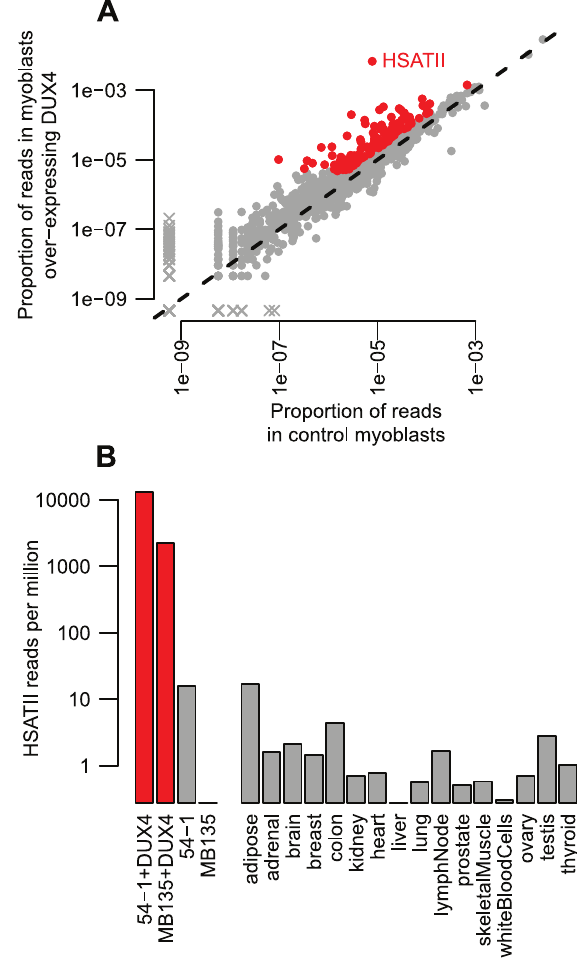
Figure 6. Read-based enrichment analysis of RNA-seq data shows activation of several repeat types. (A) For each repeat type, we show the proportion of RNA-seq reads in two myoblast cell lines transduced with lentiviral DUX4 (y-axis) compared to the proportion from the same two myoblast cell lines without DUX4 transduction (x- axis). Repeats plotted in red show $ 2-fold activation and $ 1000 reads summed across the two DUX4 -expressing myoblast lines. The HSATII repeat is labeled. As in Figure 1A, to ensure all repeat types are shown on this log-scaled plot, zero values are replaced with an arbitrarily low value and points shown with an ‘‘x’’. (B) HSATII is massively activated by DUX4. For our four RNA-seq samples, and sixteen ‘‘Body Map’’ tissues sequenced by Illumina, we show the proportion of reads that match HSATII pericentromeric satellite repeats on a log10-scale. DUX4 - expressing cell lines are shown in red, and have a much higher level of HSATII expression than any other sample surveyed. DUX4 targets (according to our DUX4 -transduced myoblast data) were detected in the testis RNA-seq despite our ability to detect all tested transcripts by RT-PCR (see Table 2) most likely because only a small proportion of cells in the testis express DUX4 [9].